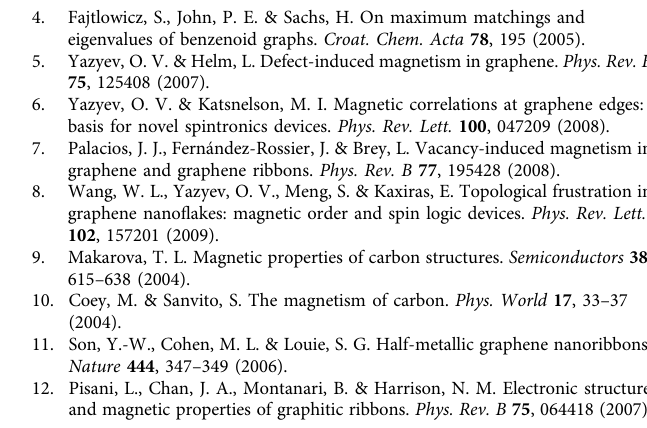
**Exchange-coupling strength J extracted from experimental (simulation) data. C1 , C2 , and C3 are the connecting con fi gurations denoted in Figs. 3, 4 in the main